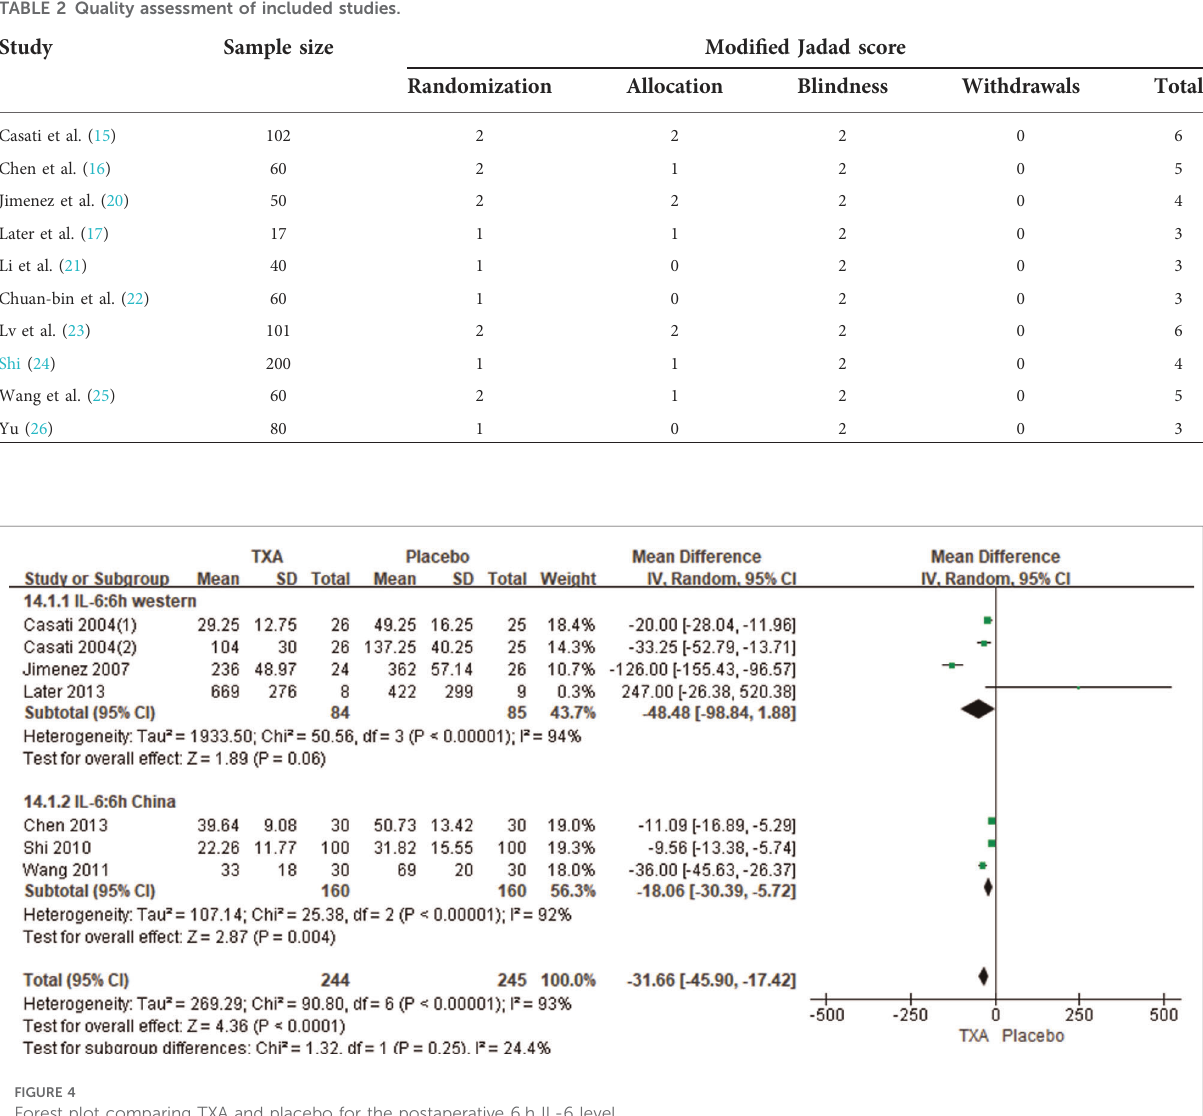
TABLE 2 Quality assessment of included studies.